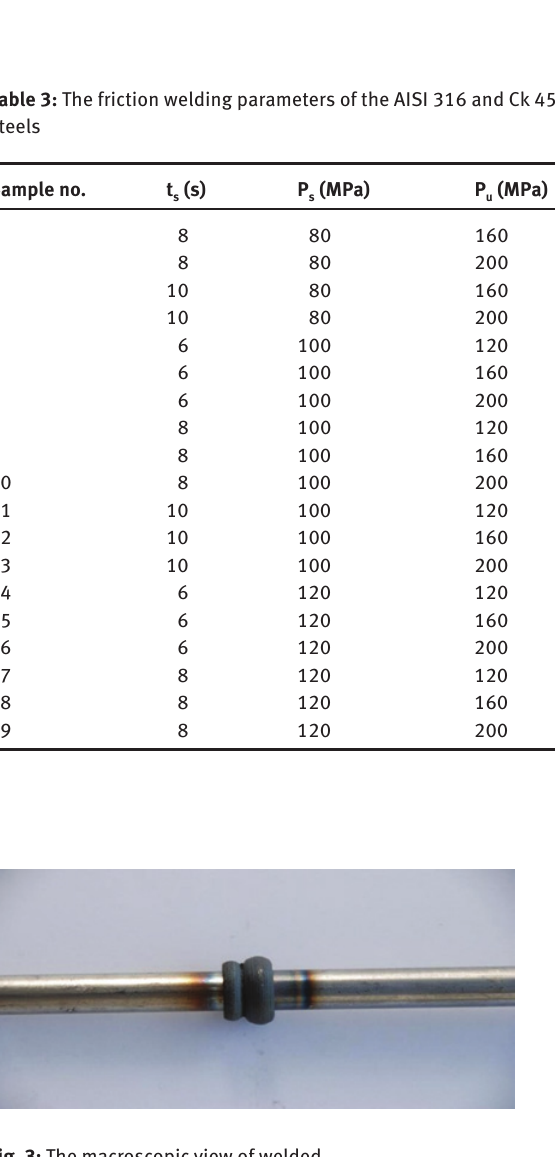
Fig. 3: The macroscopic view of